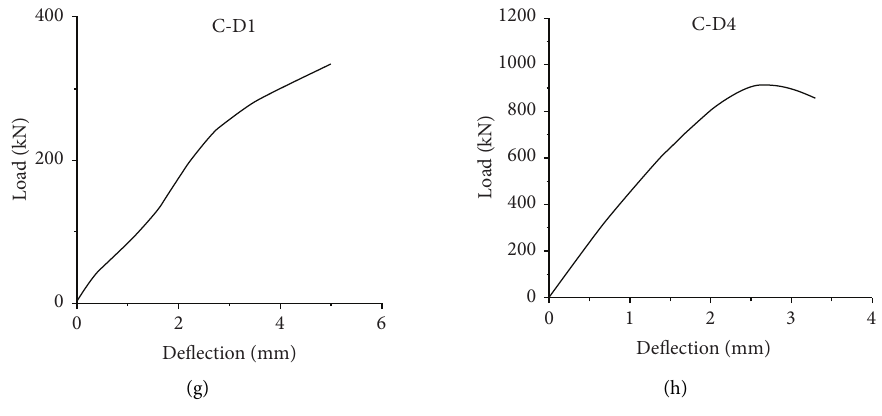
Figure 7: Load-deflection curve of the